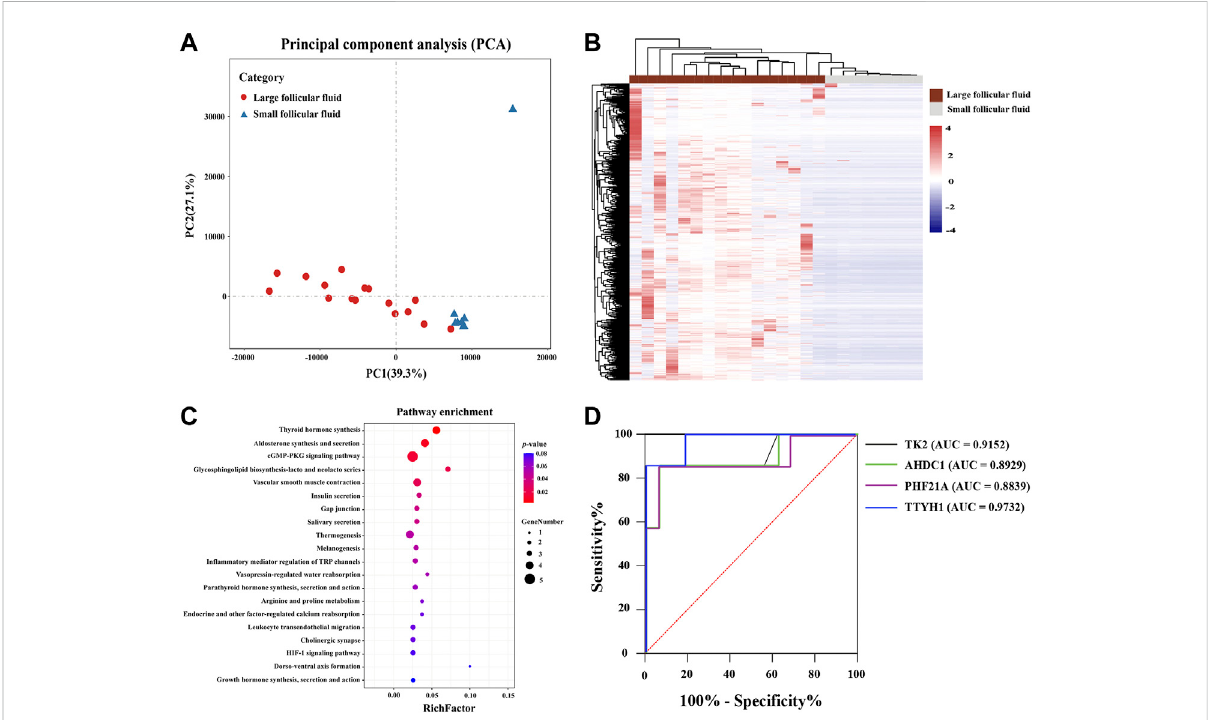
FIGURE 7 (A) PCA plot shown follicular fl uid cell-free RNA expression pattern per sample. (B) Heatmap of differentially expressed RNAs between large follicular fl uid and small follicular fl uid. Each column represents a separate sample, and each row represents a gene. Red indicates high expression, and purple indicates low expression; KEGG pathway enrichment analysis for differentially expressed RNAs is shown in (C) , which was conducted using DAVID. (D) ROC curves showed the analysis of four cell-free RNAs in predicting the different-sized follicles ’ follicular fl uid. Black, green, red, and blue represent TK2, AHDC1, PHF21A, and TTYH1, respectively. Red line represents the reference